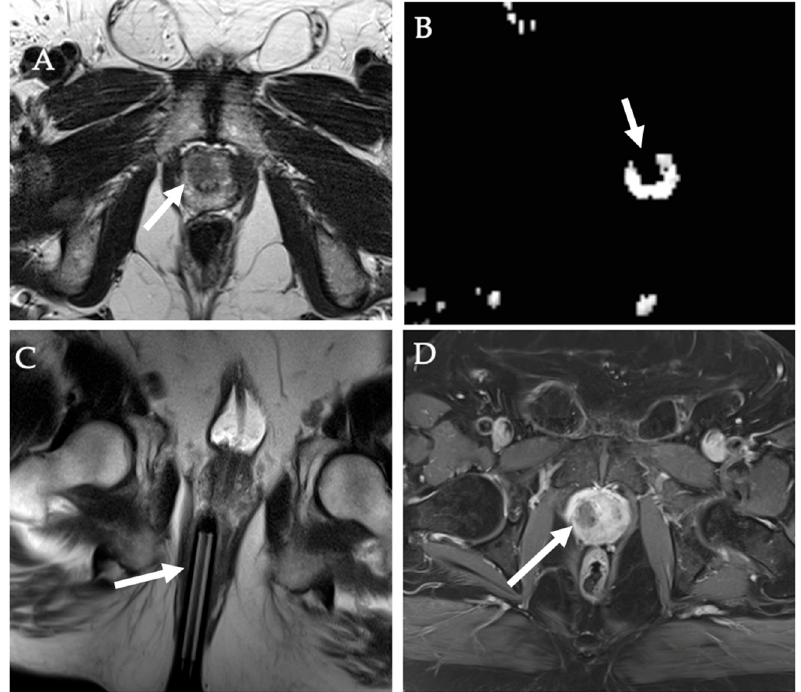
Figure 14. Laser ablation of prostate tumor . ( A , B ) Axial T2WI ( A ) and ADC ( B ) MR images show a right transition zone prostate lesion (white arrow) in a 66-year-old male with rising PSA and MR Bx positive for a Gleason score of 3 + 3 = 6 cancer. MR-compatible 18G biopsy gun deployed into the target during in-bore MR biopsy ( C ). ( D ) Subsequent MR-guided focal laser ablation was performed, with post-ablation contrast-enhanced T1WI showing complete necrosis of the target